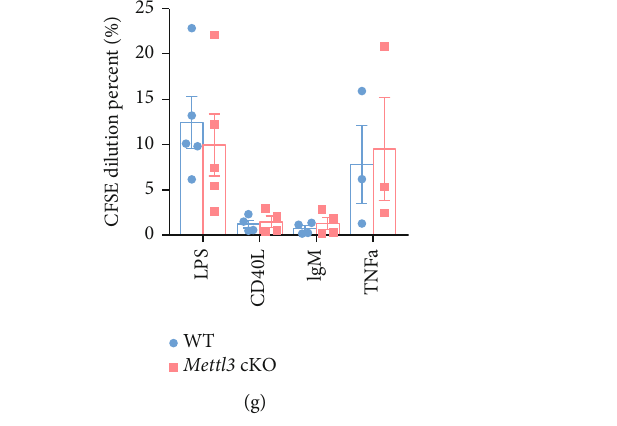
Figure 5: Knockout of Mettl3 promotes B cell apoptosis, but barely a ff ects proliferation. B cells were isolated from the spleen of WT and Mettl3 cKO mice using CD19 microbeads and treated with LPS (2 μ g/ml), CD40L (200ng/ml), anti-IgM (1 μ g/ml), or TNFa (50 ng/ml). Cells were cultured for 2 days, then collected and subjected to fl ow cytometry. (a) – (e) Representative fl ow cytometry plots (a) and quanti fi cation (b) – (e) of indicated populations in indicated groups. (f, g) B cells were isolated from the spleen of WT and Mettl3 cKO mice, labeled with CFSE, treated with LPS (5 μ g/ml), CD40L (200ng/ml), anti-IgM (2 μ g/ml), or TNFa (50 ng/ml) for 5 days, then collected and subjected to fl ow cytometry. Representative fl ow cytometry plots (f) and quanti fi cation (g) for cytometry analysis for the proliferation of CD19 + splenic B cells in indicated groups. Data in (b) – (e) and (g) were presented as means ± SEM with the indicated signi fi cance ( ∗∗∗ P < 0 : 001 ; student ’ s t